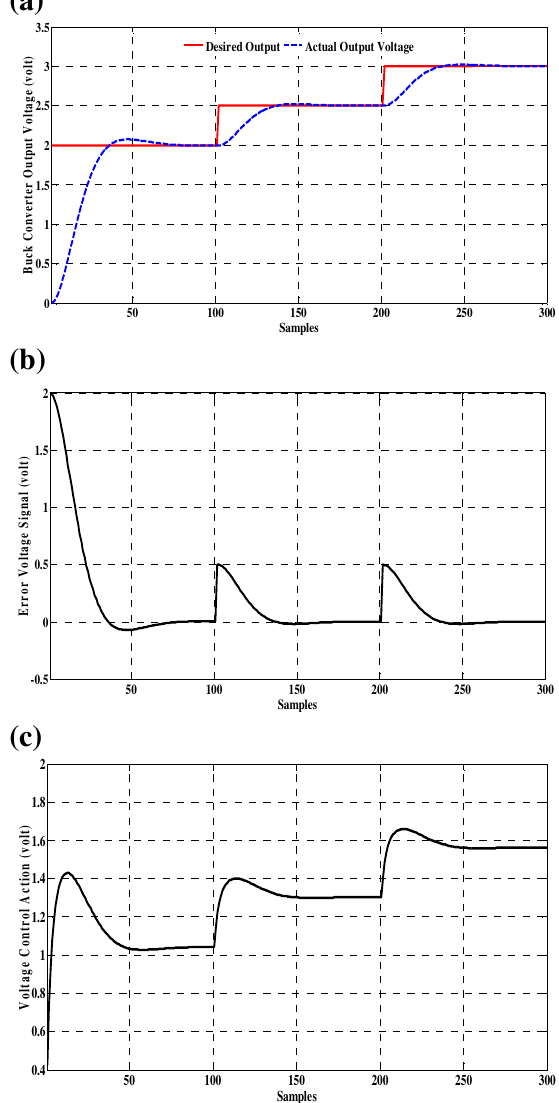
Fig. 6. Simulation results of the adaptive PID controller: (a) Output voltage for Buck converter model; (b) Voltage error; (c) Voltage control